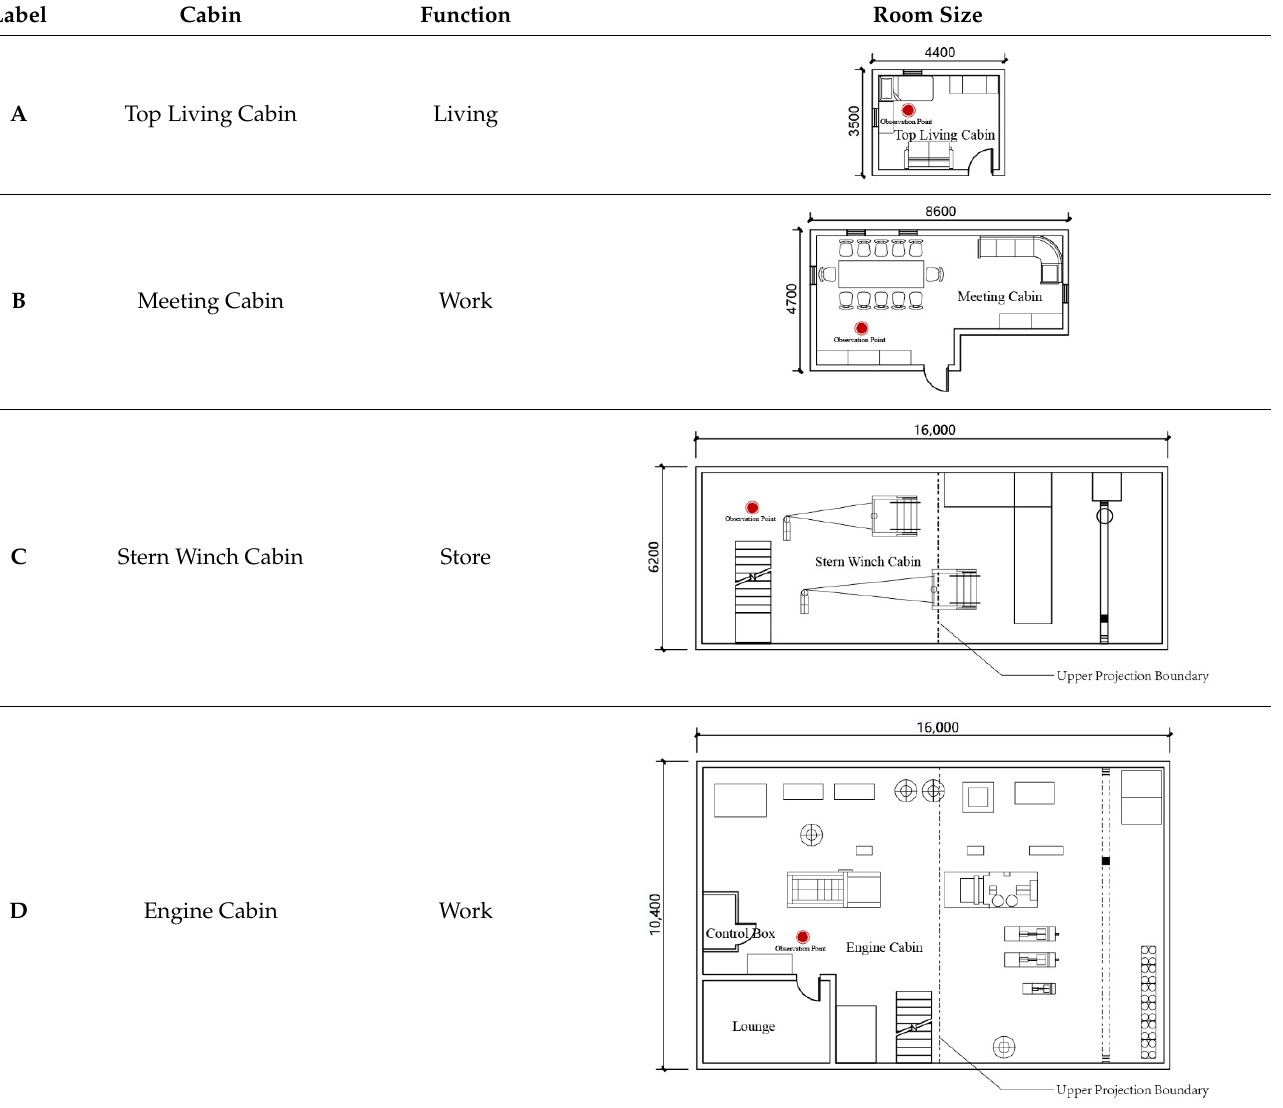
( c ) Figure 4. Bulkhead and deck construction. ( a ) Bulkhead construction, ( b ) Bulkhead profiles, ( c ) Deck construction. The sizes of the cabin portholes are very small at only 350 mm by 700 mm. Usually, they are kept closed, which is very consistent with the applicable scope of the PMV-PPD index: an indoor space with calm wind and no solar short-wave radiation. Therefore, this index was used for the thermal comfort evaluation. In the measurement, this study aimed to: (1) conduct a quantitative analysis of the variations in temperature, humidity, and other parameters in order to evaluate the ther- mal comfort of different cabins under direct solar radiation, water contact, and other fac- tors; (2) conduct qualitative research on correlations between the ship’s hull and factors such as water and solar radiation to evaluate thermal comfort. Cabins A, B, C, and D are in different environments. Cabins A and C are directly heated by solar radiation. Cabins